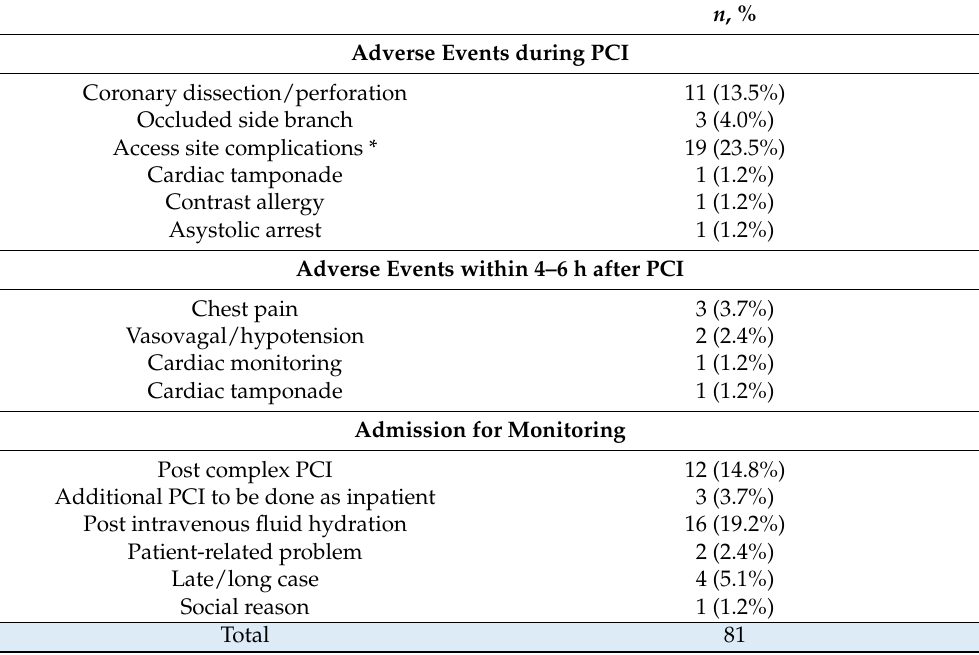
Table 6. Reasons for overnight admission post elective PCI from 2017 to 2019.